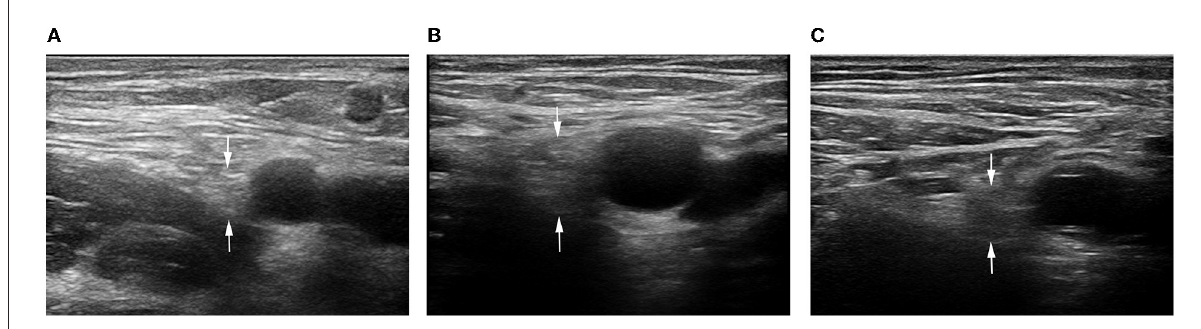
FIGURE3 2D ultrasound image of the FN. (A) Control subject; (B) patient with T2DM, non-DPN group; (C) patient with T2DM, DPN group.